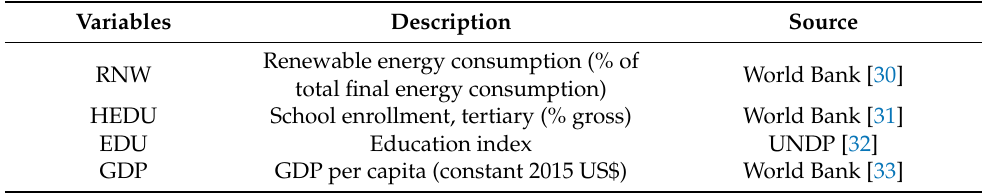
Table 2. Dataset